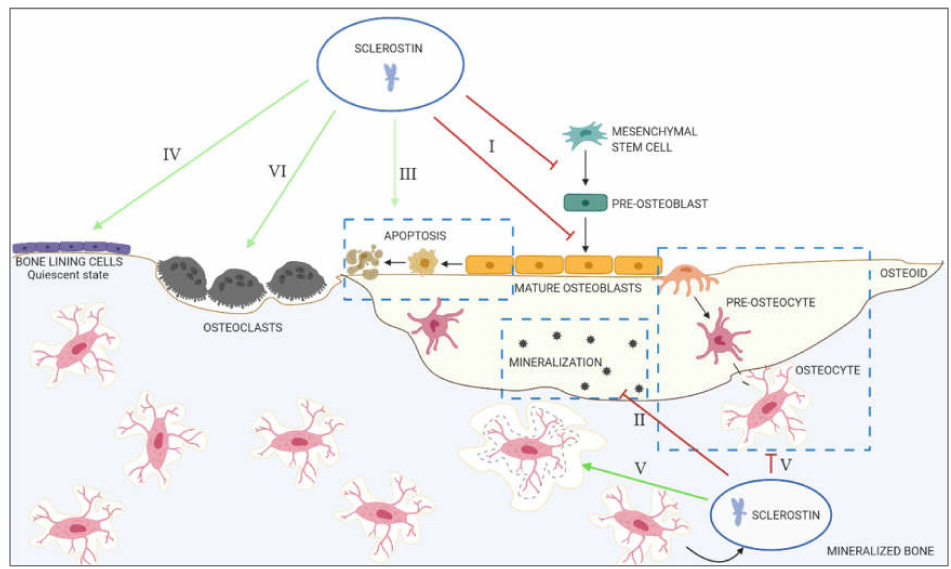
Figure 1. Overview of the actions of sclerostin in the bone. I: Inhibition of proliferation and di ff erentiation of osteoprogenitor / pre-osteoblastic cells, as well as decreased activation of mature osteoblasts; II: decreased mineralization; III: increased apoptosis of the osteogenic cells; IV: maintenance of bone lining cells in their quiescent state; V: regulation of osteocyte maturation and osteocytic osteolysis; VI: stimulation of bone